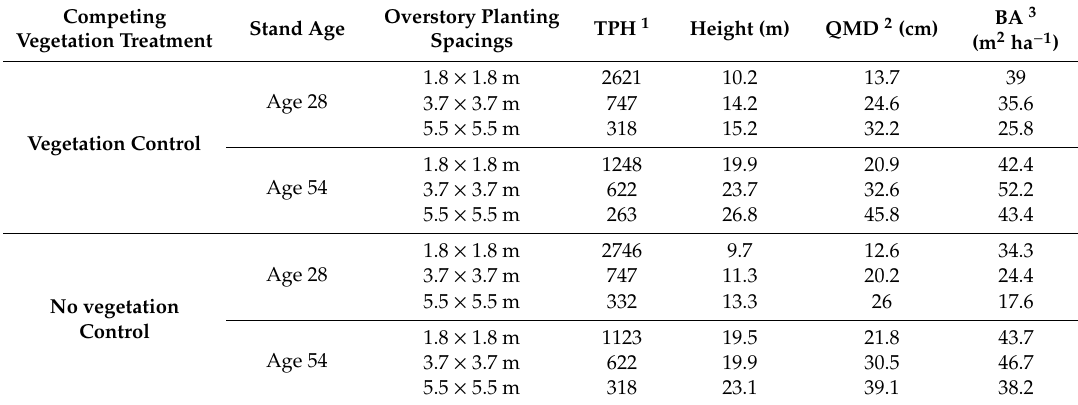
Table 1. Stand characteristics of ponderosa pine subplots used in this study at Challenge Experimental Forest, California. Treatments are three levels of planted spacings of pine and two vegetation controls of competing vegetation in a split plot